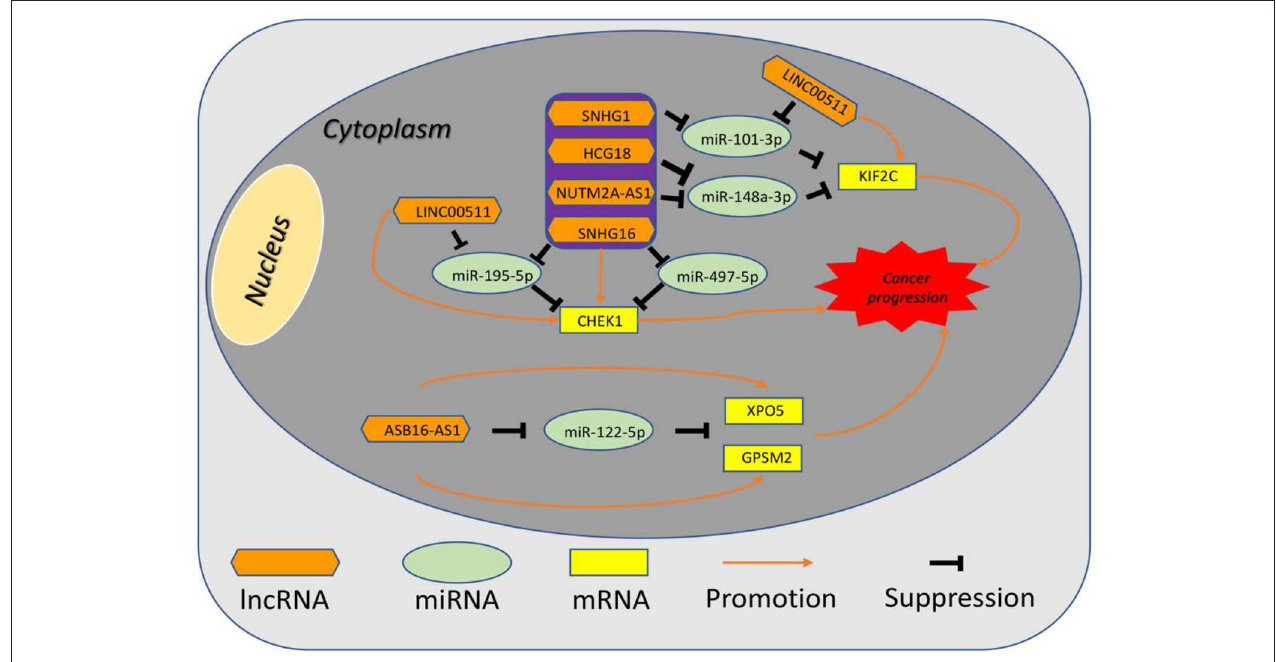
FIGURE 10 | The established mRNA-miRNA-lncRNA competing endogenous RNA (ceRNA) triple network associated with progression and prognosis of hepatocellular